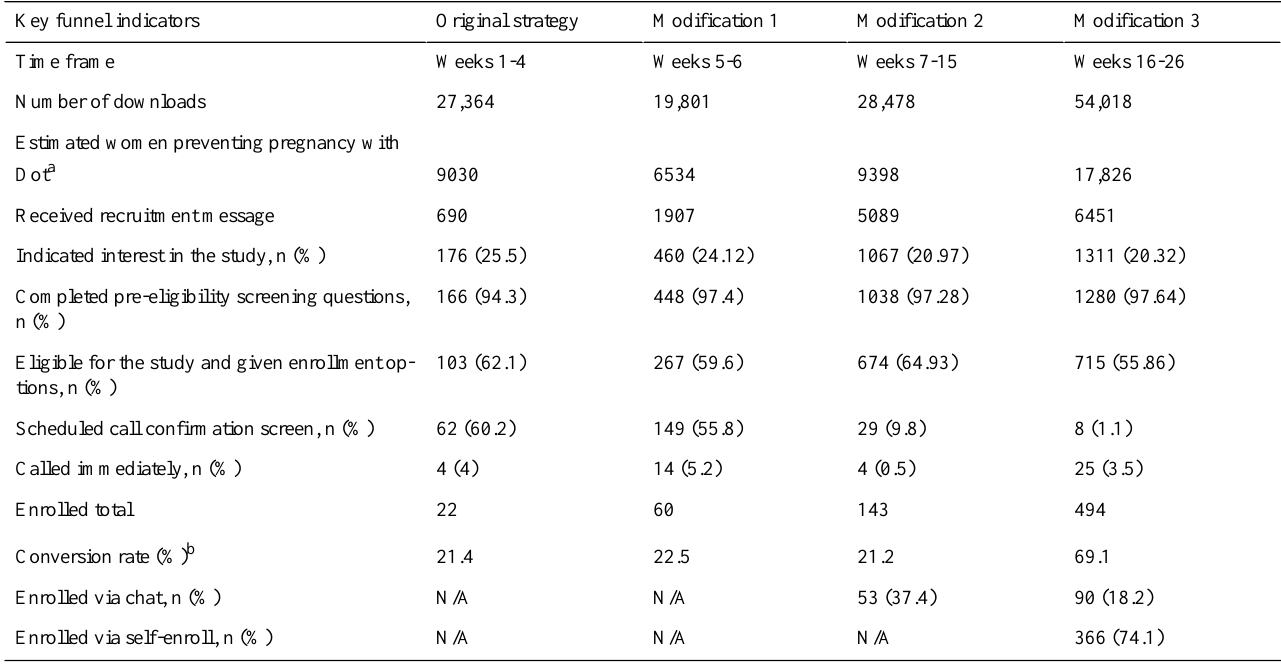
Table 2. Recruitment and enrollment funnel results during each modification strategy. N/A: not